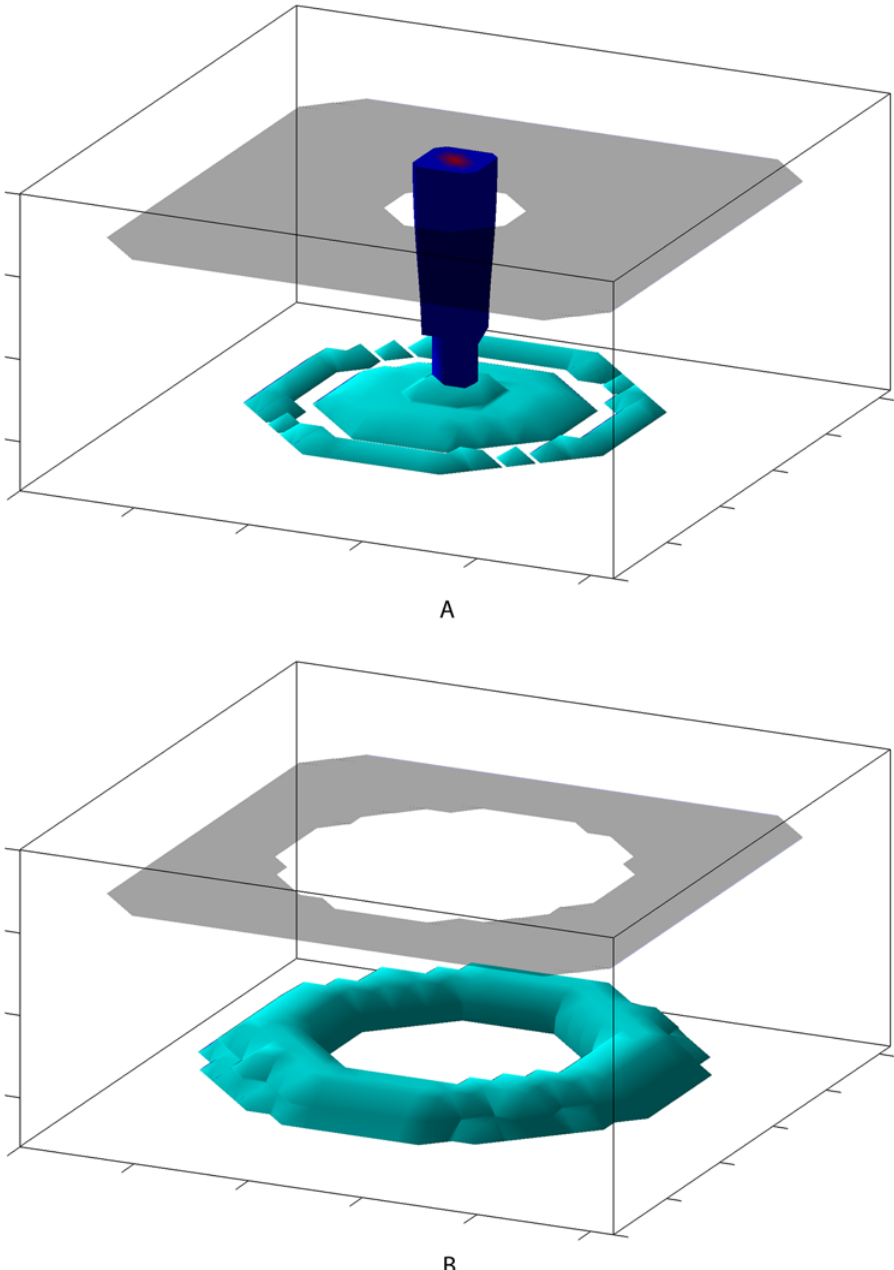
Figure 8. Isosurfaces of a metastatic primary tumor before and after resection. Primary tumor (blue), metastases (cyan), and the basement membrane (gray) are shown. (A) The primary tumor at a steady state along with suppressed metastases. The exact picture shown is representative of the fluctuating metastatic load, which varies somewhat, although the overall behavior is one of a quasi-steady state. (B) Metastatic recurrence 6 months after resection of the primary tumor. The resection was successful in removing all material from the primary tumor, but the total mass of the metastases already exceeds that of the primary tumor.